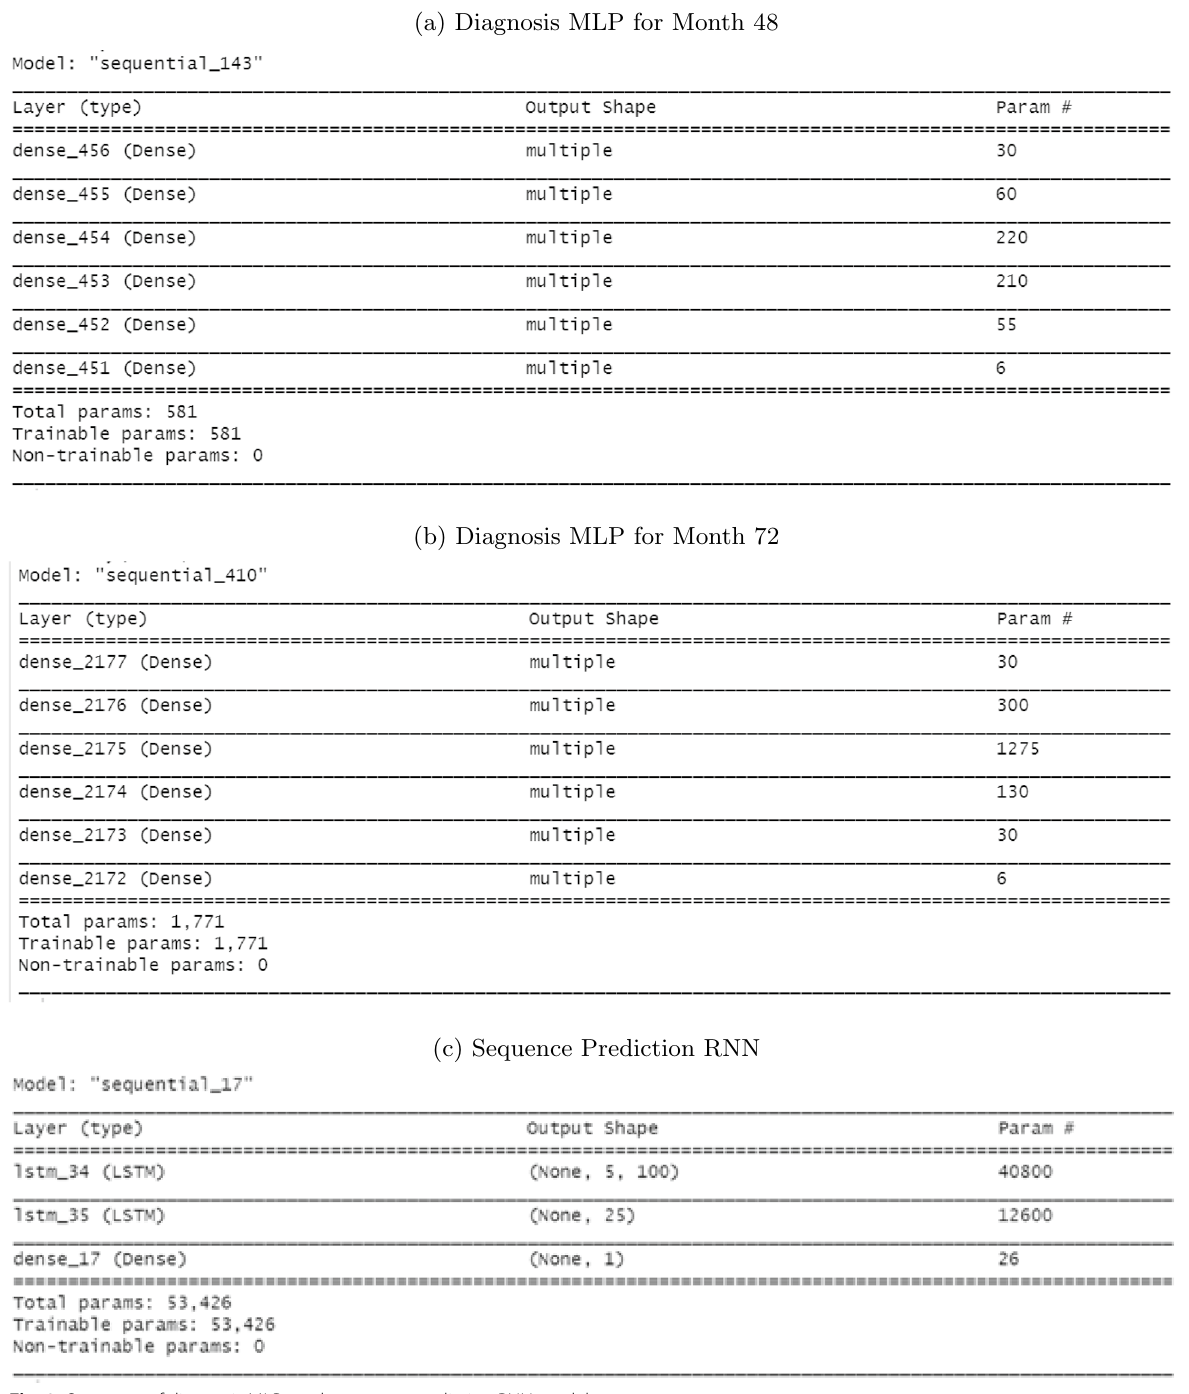
Fig. 3 Summary of diagnosis MLPs and sequence prediction RNN